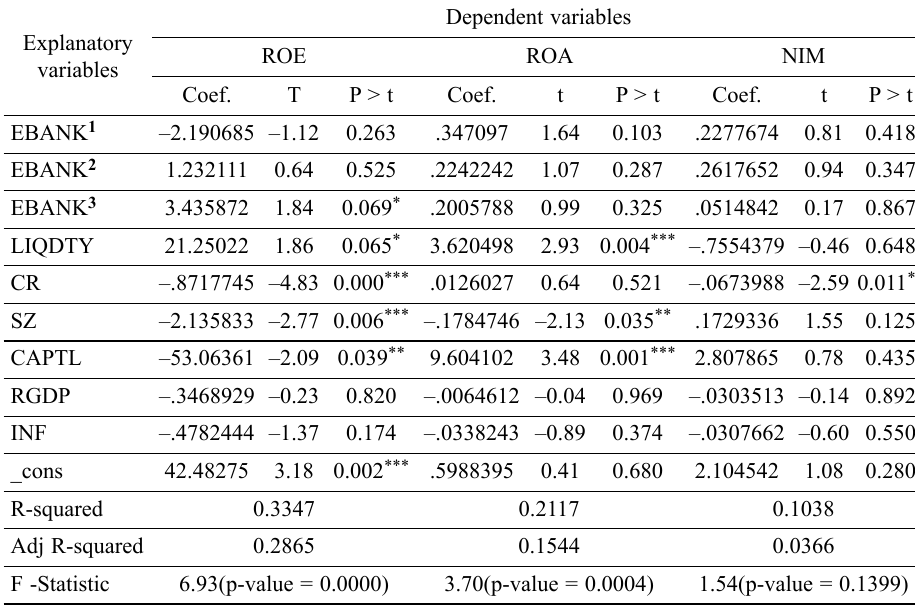
Table 4. Estimated results with pooled